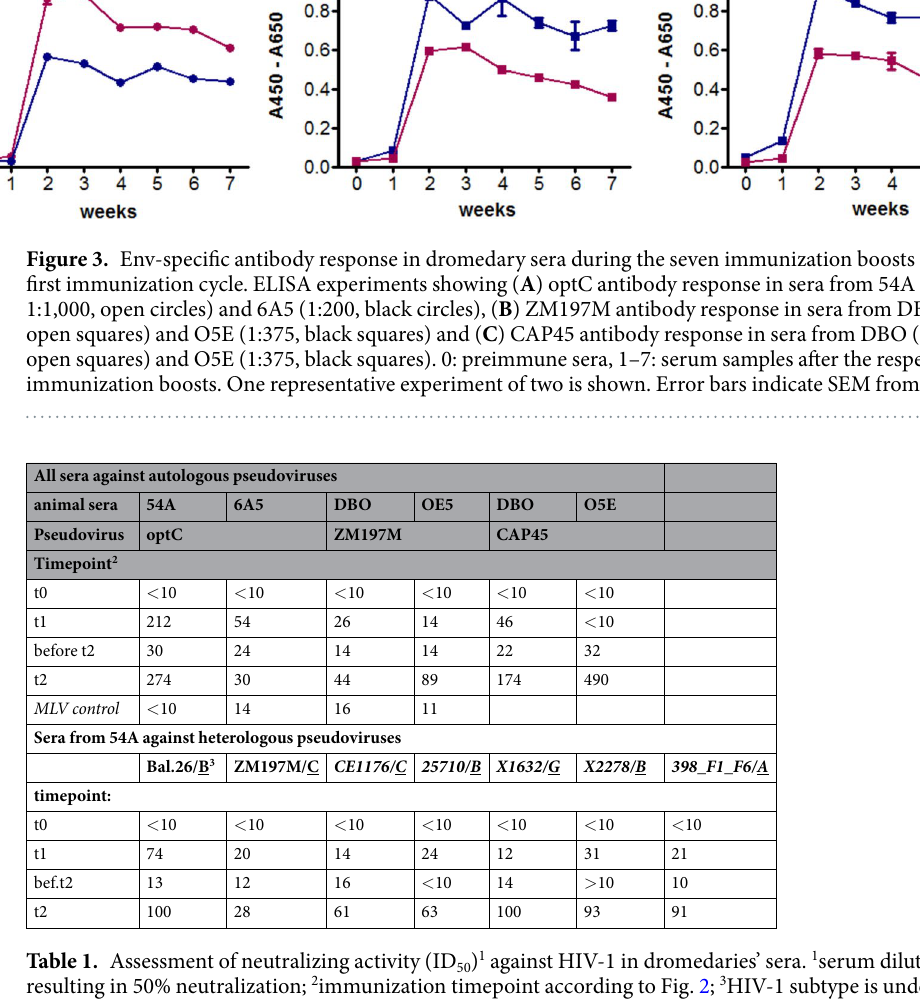
different soluble trimeric subtype C SOSIPs resulted in the induction of an HIV-specific neutralizing activity in the immune sera against heterologous isolates from different clades. Selection of nanobodies with broad neutralizing activity against heterologous Tier 2 HIV-1 subtypes from VHH phage libraries. VHH phage libraries were generated from all four animals starting from lymphocyte RNA from early and late immunization timepoints (t1 and t2, Fig. 2), respectively. After PCR amplification of VHH sequences from cDNA, cloning and plating, 95–100% of bacterial colonies were positive by colony PCR. Titers of the bacterial libraries ranged from 4 × 10 8 –2 × 10 9 cfu/ml and the titers of the correspond- ing phage libraries after superinfection with Hyperphage were 1 × 10 12 pfu/ml. After three rounds of selection on the autologous gp140 SOSIPs, about 1300 randomly picked clones were first analyzed by phage ELISA followed by soluble VHH ELISA. Eighty clones were found to bind in both settings. Sequencing of the VHH inserts revealed nanobodies from 25 different families. For a rapid initial assessment of the neutralizing activity of the selected VHHs, periplasmic lysates of the 25 families were analyzed in vitro in the TZM-bl assay for neutralization of the pseudoviruses Bal.26 (subtype B, tier 1B) and optC (ancestral subtype C used as immunogen, Tier 2 (not yet determined officially)). Eight VHH clones showing neutralizing activity against one or both pseudoviruses were recloned into the pCAD51 expres- sion vector (outside the PIII phage context), expressed in E. coli and purified via Ni-NTA chromatography. All eight sequenced VHHs show characteristic long CDR3 sequences 28 in the range of 19 to 21 amino acids (Table 2) as well as the presence of a cysteine (except VHH-43) able to stabilize the extended CDR3 loop by pairing with a cysteine in CDR1.